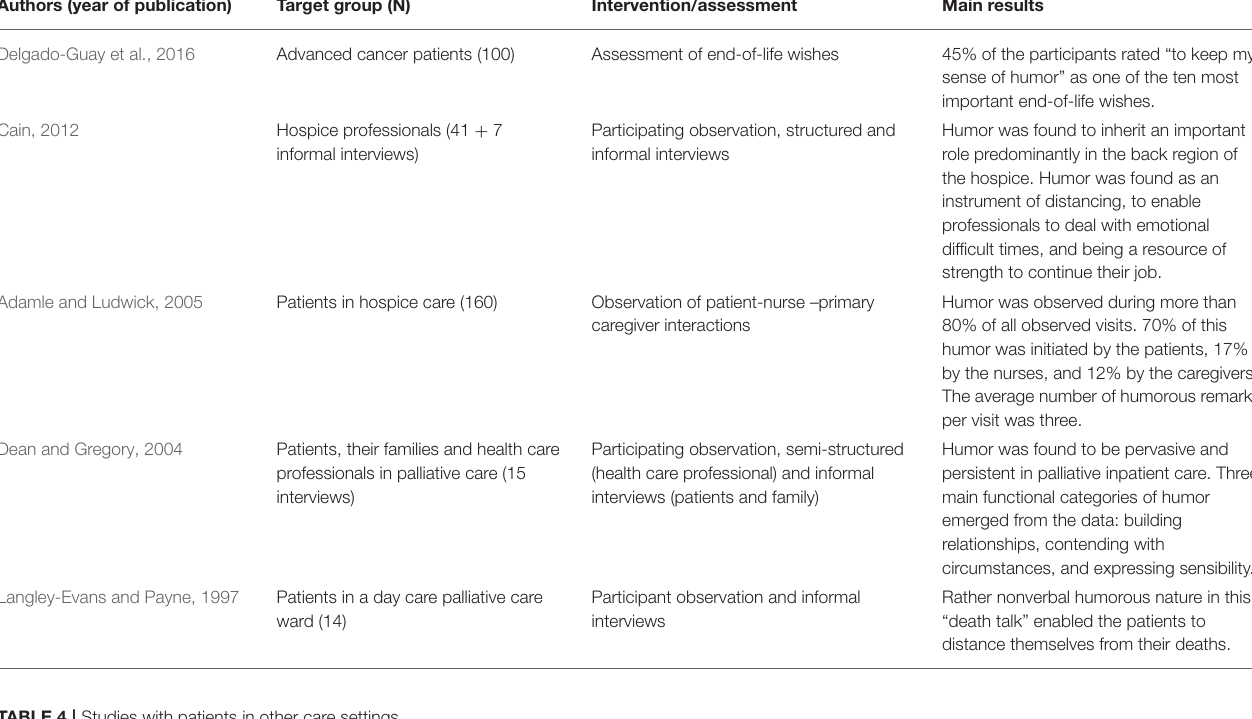
TABLE 3 | Studies assessing functions and results of humor application.